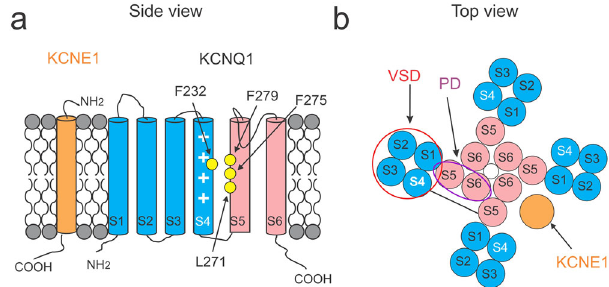
Fig. 1 The topology of KCNQ1 and KCNE1. a Schematic side view of one KCNQ1 subunit and one KCNE1 subunit in orange. S1 – S4 form the voltage- sensing domain (VSD) in blue while S5 – S6 the pore domain (PD) in pink. The white plus symbols in S4 represent the positive gating charges. Residues mutated to study the mechanism of VSD – PD coupling are indicated in yellow. b Schematic top view of a tetrameric KCNQ1 channel with one KCNE1 subunit. The number of KCNE1 varies from 1 to 4. One VSD (red circle) from one subunit is close to one PD (purple oval) from its neighboring subunit. S4 is linked to S5 by an S4 – S5 linker within the same